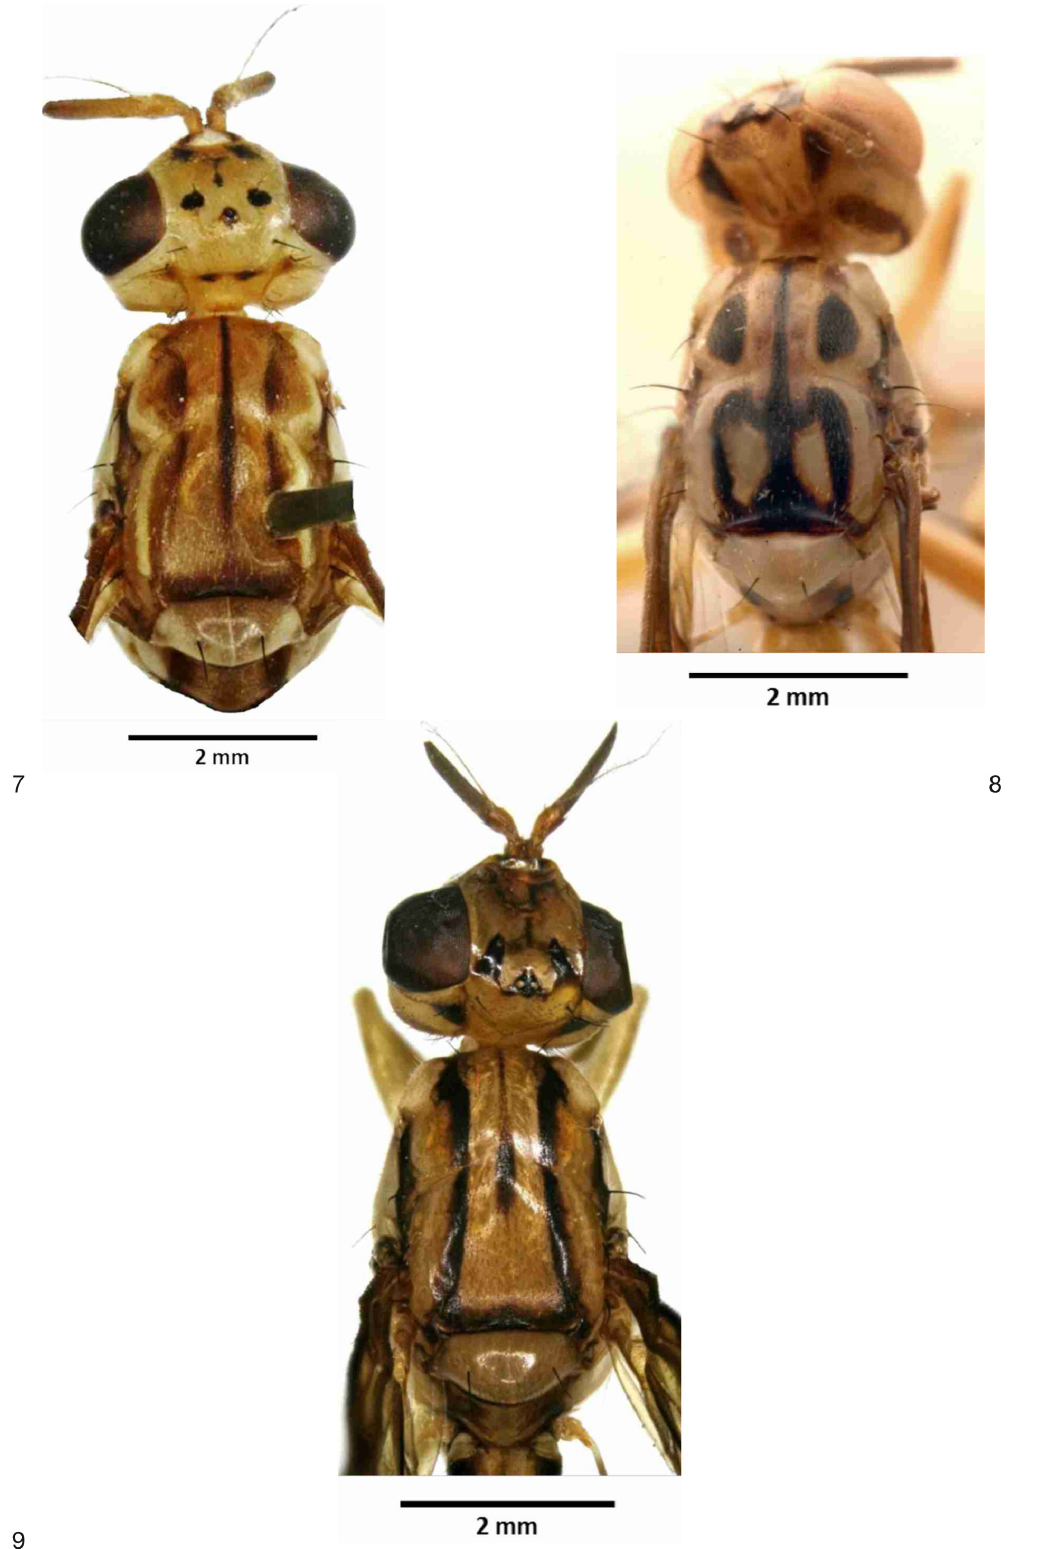
Figs 7–9. Ichneumonopsis spp., head and thorax, dorsal view. 7 . I. burmensis Hardy, 1973. 8 . I. hancocki sp. nov. 9 . I. taiwanensis sp.